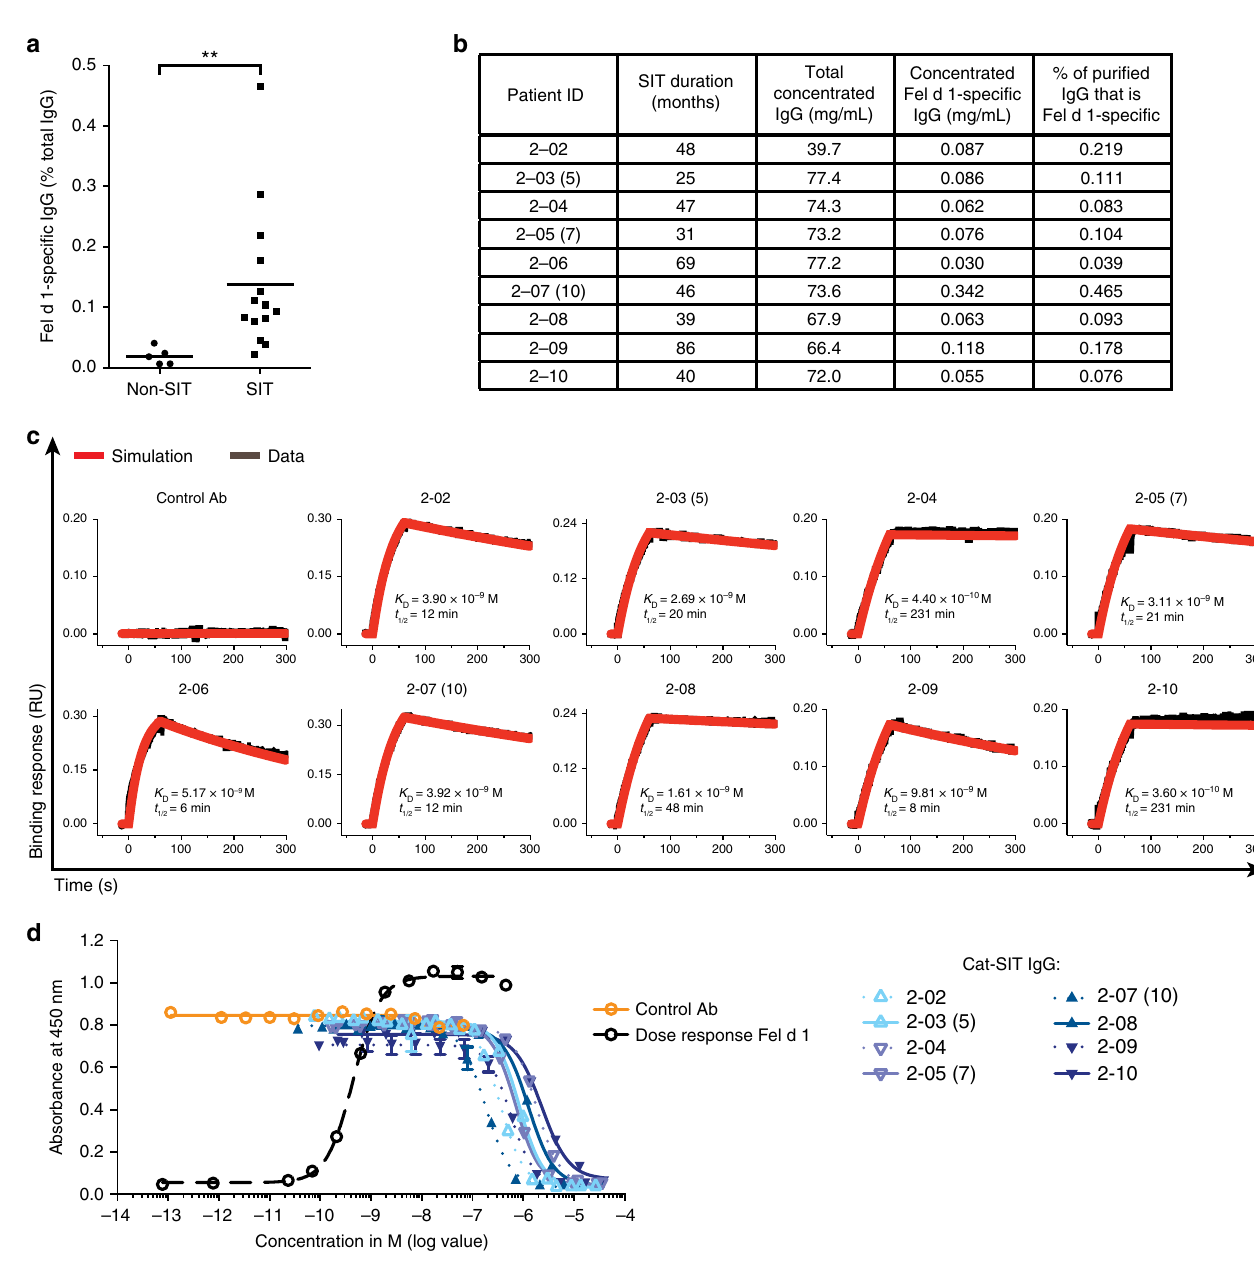
Fig. 1 Speci fi c immunotherapy (SIT) is associated with increased allergen-speci fi c IgGs which have varying af fi nity between patients and block binding of Fel d 1 to IgE with variable potency. a Fel d 1-speci fi c IgG titers were measured as a percentage of total IgG in cat-allergic Non-SIT ( n = 5) and Cat-SIT ( n = 14) patient sera by ELISA. Mean (line) and individual patient data representing the average of duplicate wells (dots) are shown. Statistical analysis was assessed by Mann – Whitney two-tailed test. b Individual patient data for samples used in ( c ) and ( d ). Patient IDs with parentheses denote three patients who donated blood at two visits. The number in parentheses represents donor ID from the fi rst visit. Binding parameters presented here are based on sample obtained from their second visit. Samples from the fi rst visit were used in the PCA Model, Fig. 4. c Puri fi ed and concentrated Cat-SIT-IgG samples from individual patients binding to rFel d 1 was assessed on a HTX biosensor platform. The rFel d 1.mmh was captured on anti-penta-His (HIS1K) Octet biosensors and dipped in samples containing 100 nM of Fel d 1-speci fi c IgG. d Puri fi ed and concentrated Cat-SIT IgG from the individual patients shown in b and c were assessed for the ability to block binding of a constant concentration (0.7 nM) of rFel d 1.mmh from binding to plate-captured allergen-speci fi c IgE from one cat-allergic patient in a blocking ELISA. One of two experimental replicates using different IgE donors is shown. The mean and SD from duplicate wells are plotted. Donor 2 – 06 was not included in the ELISA assay due to volume requirements of the assay. ** p <